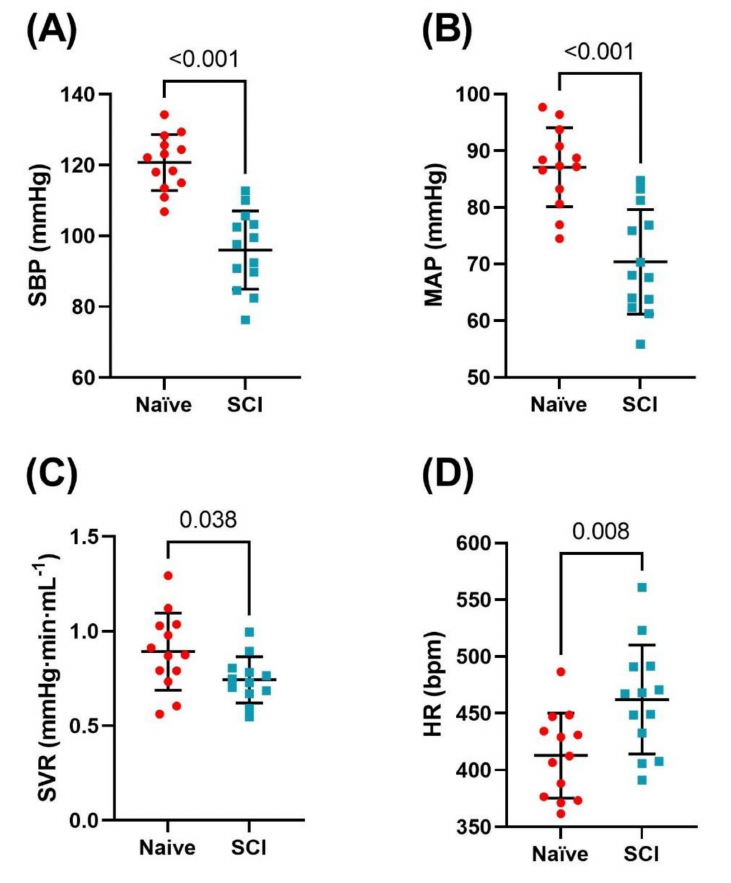
Figure 3. Comparison of resting hemodynamic indices of naïve (n = 13) and spinal cord injured (SCI) rats (n = 13) two weeks post-injury. Bars represent the means and standard deviations overlaid with individual data. ( A ) Systolic blood pressure (SBP) was significantly lower in SCI compared to naïve animals (25 ± 4 mmHg, p < 0.001). ( B ) Mean arterial pressure (MAP) was significantly lower among SCI compared to naïve animals (17 ± 3 mmHg, p < 0.001). ( C ) Systemic vascular resistance (SVR) was significantly lower among SCI compared to naïve animals (0.11 ± 0.08 mmHg · min − 1 µ L − 1 , p = 0.034). ( D ): Heart rate (HR) was significantly higher among SCI compared to naïve animals (49 ± 17 beats per minute, BPM; p =